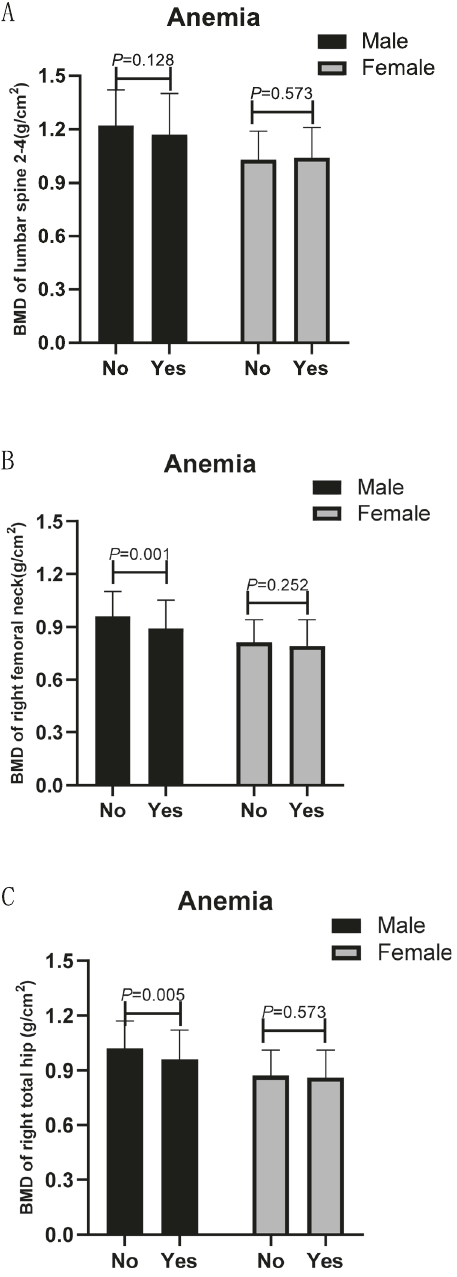
Fig. 2 BMD according to different anemia status. A BMD of the lumbar spine 2-4 according to different anemia status. B BMD of the right femoral neck according to different anemia status. C BMD of the right total hip according to different anemia status.